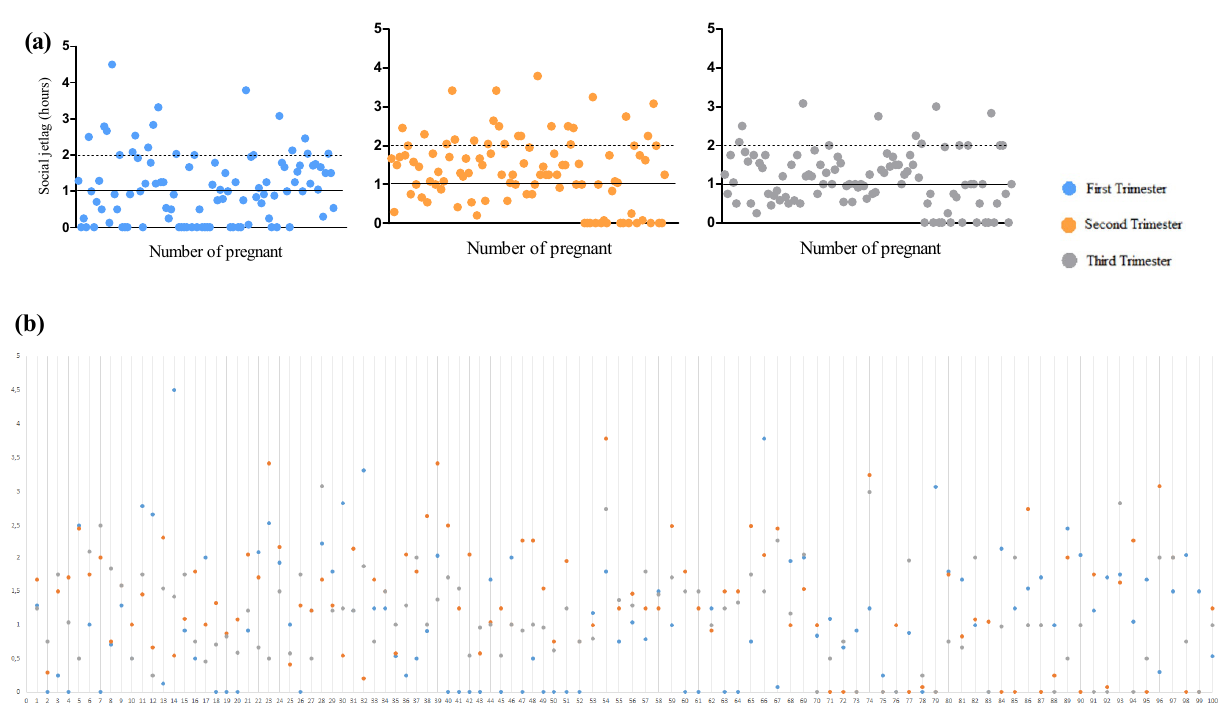
Figure 3. ( a ) Distribution of social jetlag (SJL) (hours) throughout each gestational trimester in the longitudinal phase. (b) The SJL value in hours is shown for each pregnant woman according to the three gestational trimesters (n = 100).